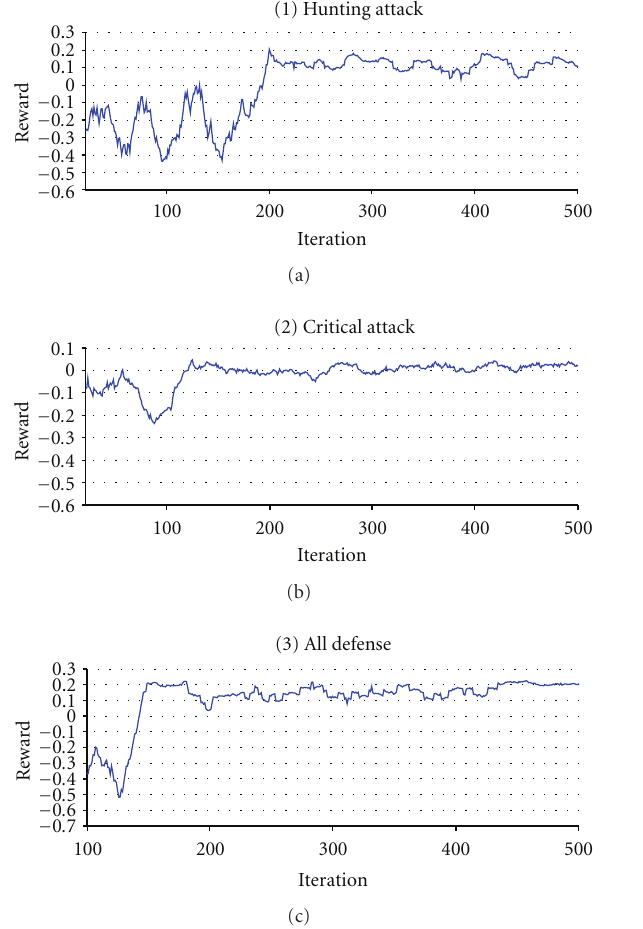
Figure 13: Generality test results for the SAP hierarchical learning framework: experiment sets 4, 5, and 6. The last three of six sets of experimental setups where each setup consists of Team B having a di ff erent fixed strategy. The exception is in the 6th set whereby Team B chooses a random strategy in each iteration. Each experiment set has the reward value plotted against the number of iterations. A single point on the graph represents a full game episode. Note that in order to maximize visibility, the scales are not uniform across all